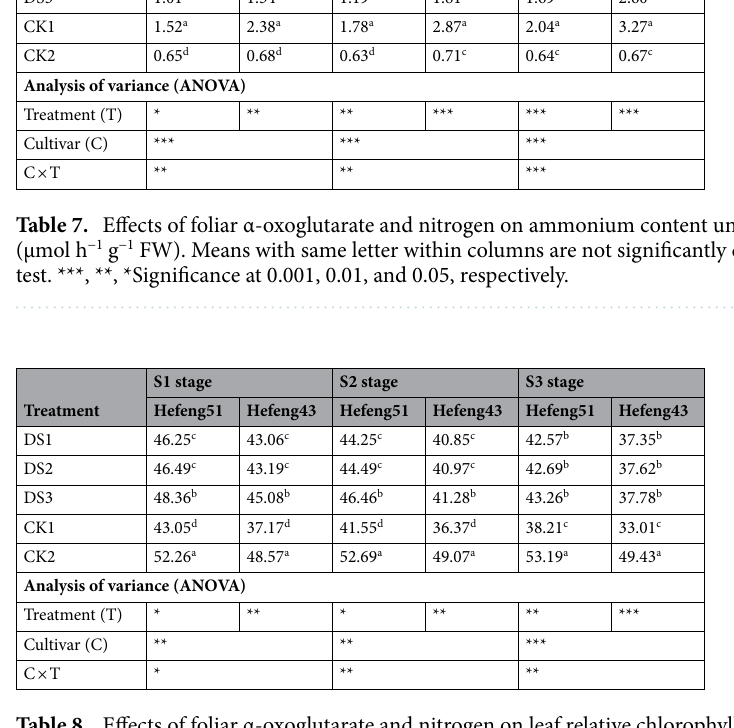
Table 8. Effects of foliar α-oxoglutarate and nitrogen on leaf relative chlorophyll content under drought stress ( SPAD ). Means with same letter within columns are not significantly different ( P < 0.05) using LSD test. ***, **, *Significance at 0.001, 0.01, and 0.05,